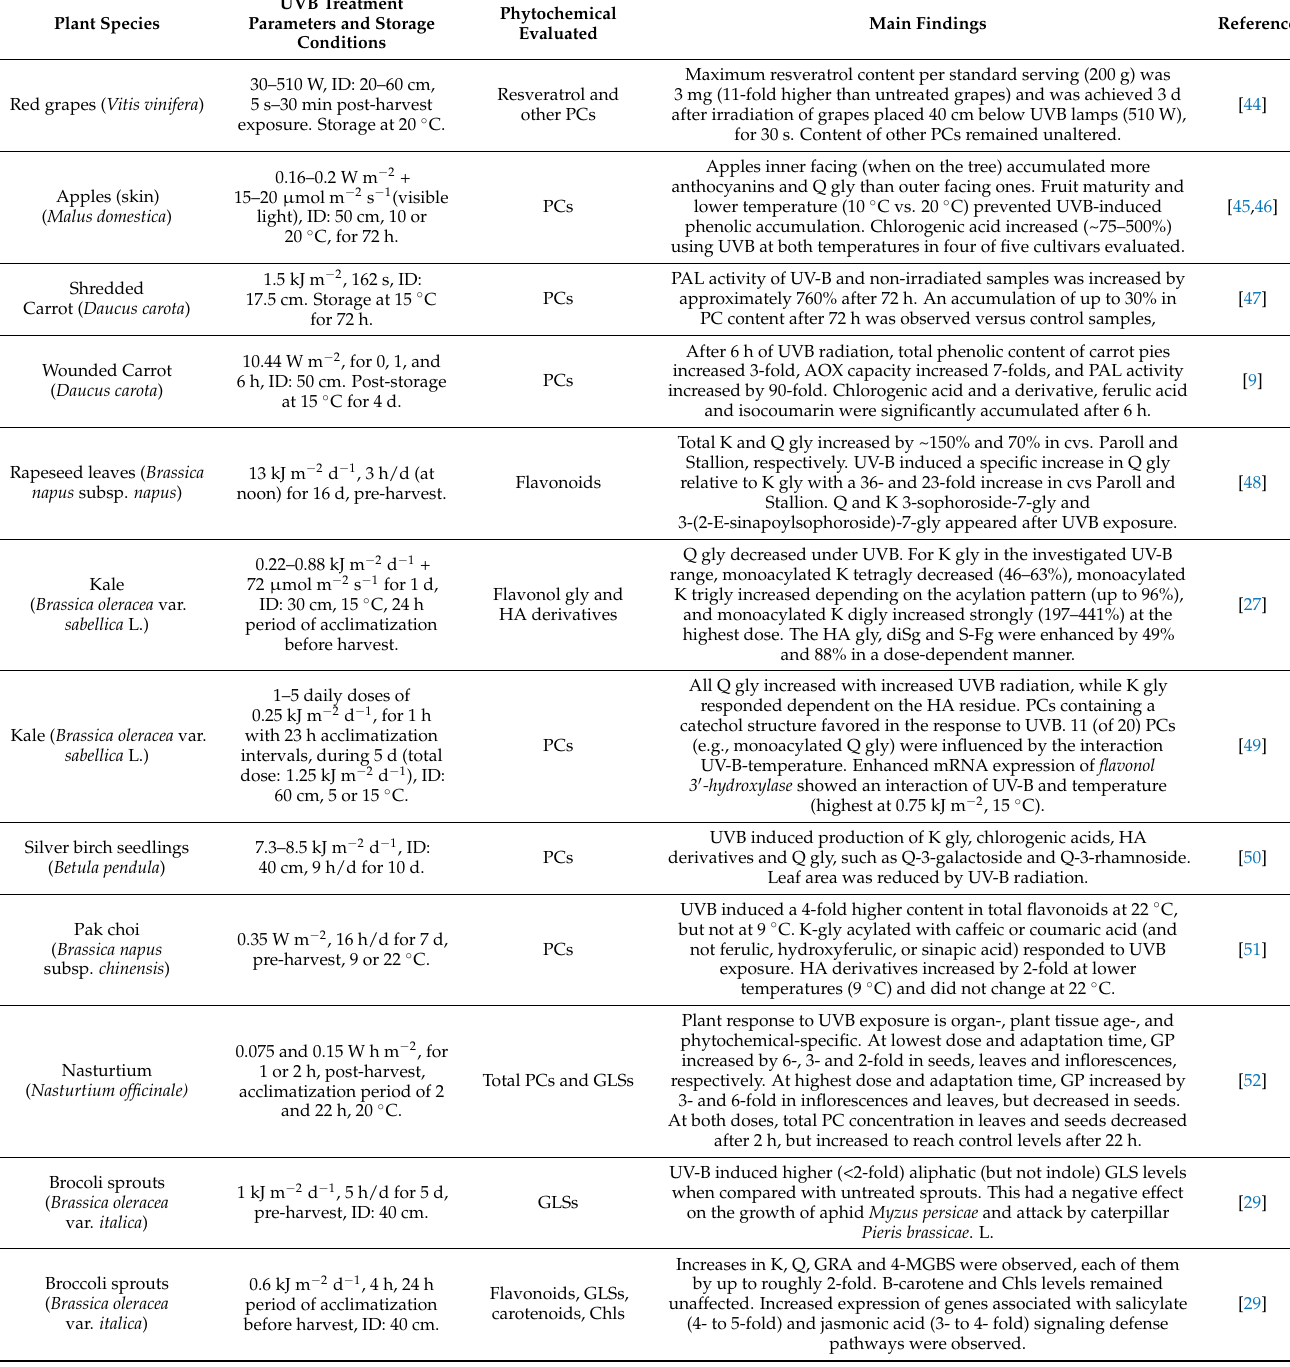
Table 1. Effect of UVB radiation on the biosynthesis of bioactive phytochemicals and on stress responses in different horticultural